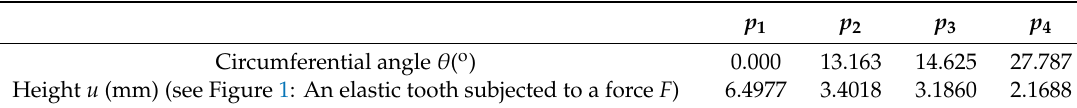
Figure 8. Effect of loading locations on tooth root shearing stress. 2.2.2. Effect of Number of Teeth on Stress Distribution This section investigates the effect of number of teeth on gear tooth root stress distribution. Gear parameters are given in Table 3 except we test 3 different teeth. A force F (contact force per unit of tooth width F / b = 10 N/m) is applied on the tooth tip. With the increase of the number of teeth, the tooth root normal stress and shearing stress decrease slightly, and the circumferential angle range covered by a single tooth will become smaller, as shown in Figure 9.